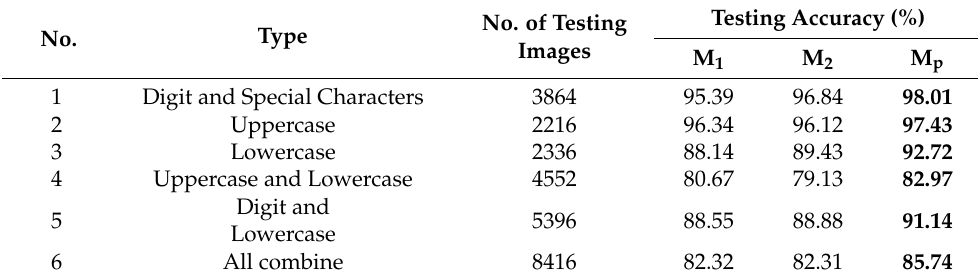
Table 4. Comparison of testing accuracies with different